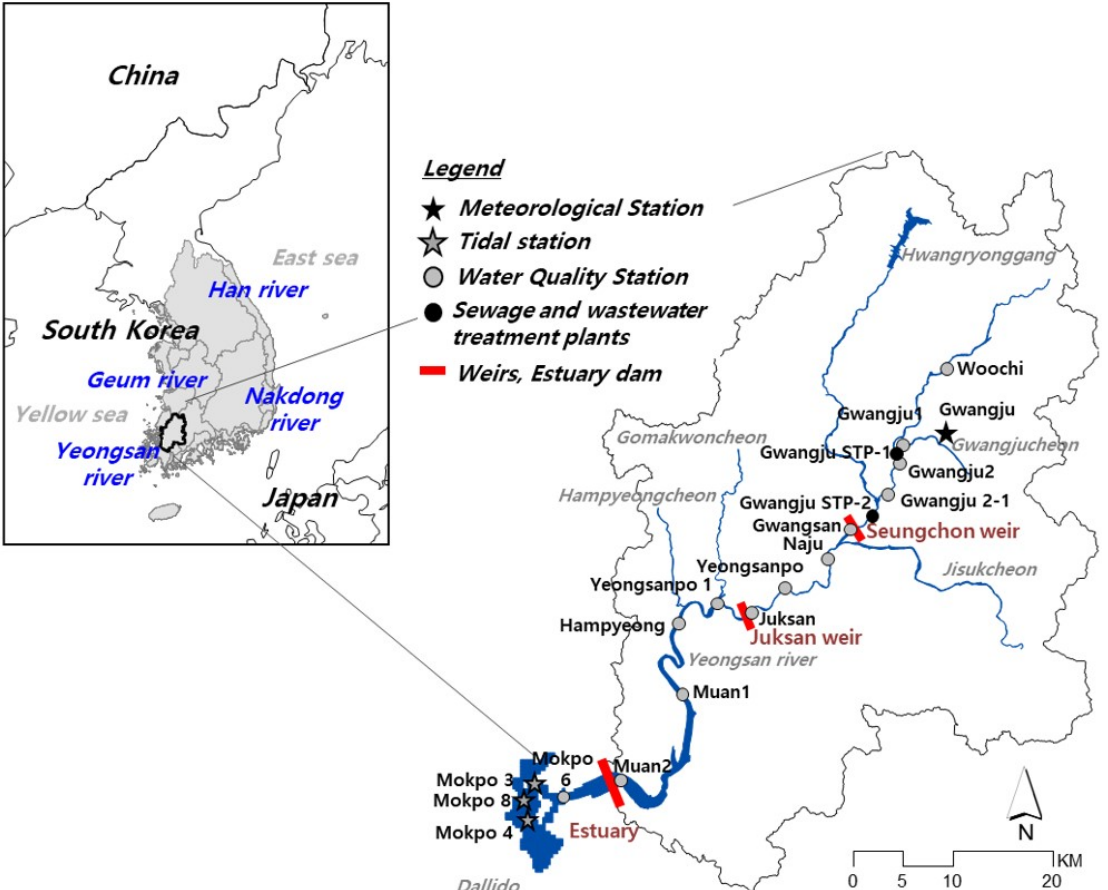
Figure 1. Site map showing the location of the Yeongsan River in Korea and its major tributaries and monitoring stations.